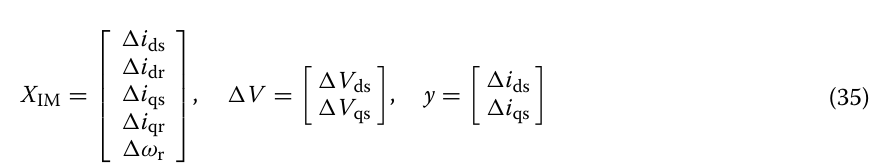
Here, state variable X IM , (cid:31) V and y are represented by the following equation